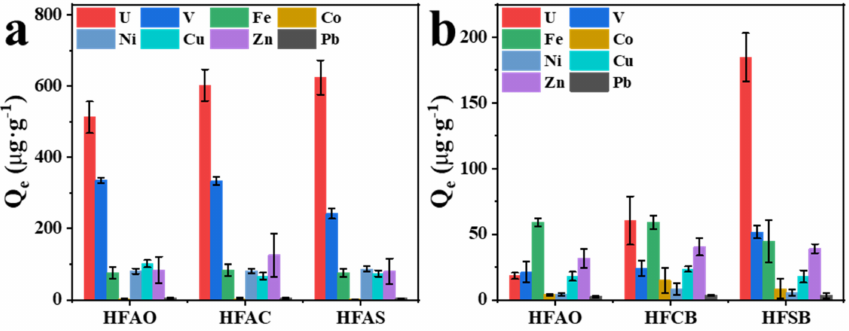
Figure 4. Adsorption capacity of HFAO, HFAC, and HFAS in ion competing solution ( a ) and seawater ( b